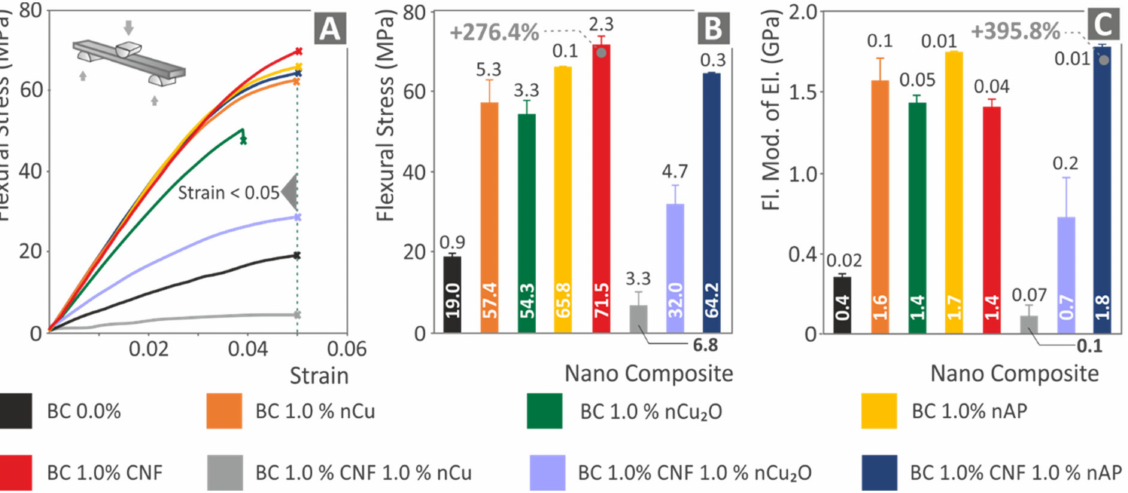
Figure 12. Flexural test results: ( A ) typical stress (MPa) vs. strain (mm/mm) graphs for all materials, ( B ) average flexural strength (MPa) and deviation for all materials, and ( C ) average flexural modulus of elasticity and deviation for all